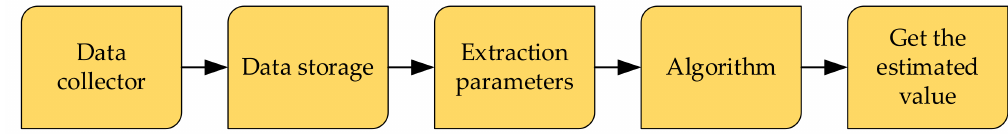
Figure 14. The process of data-driven